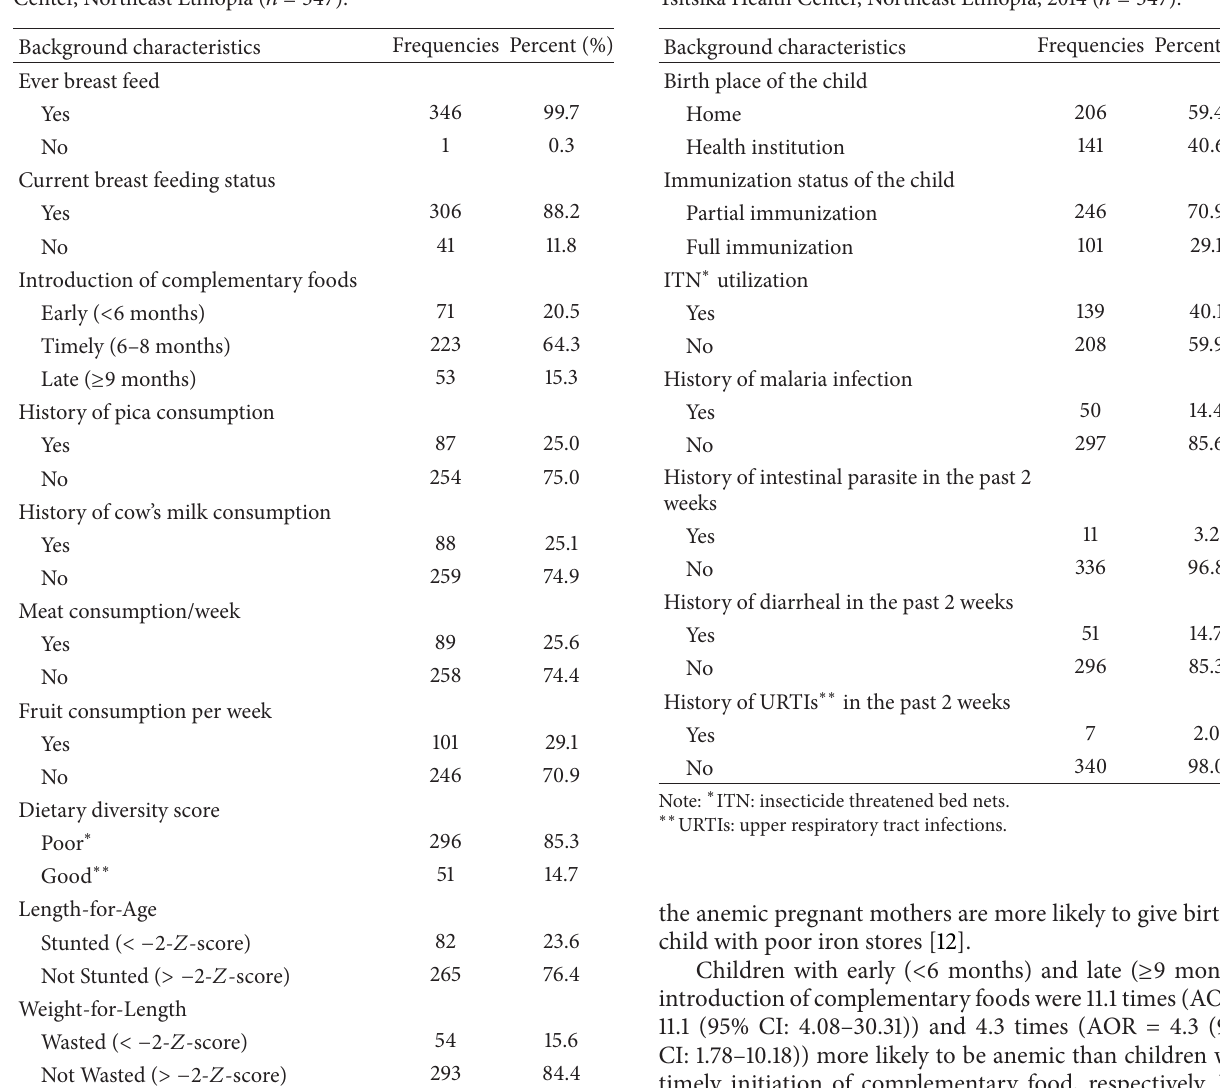
Table 3: Morbidity and health care related characteristics of children aged 6–23 months attending growth monitoring clinic